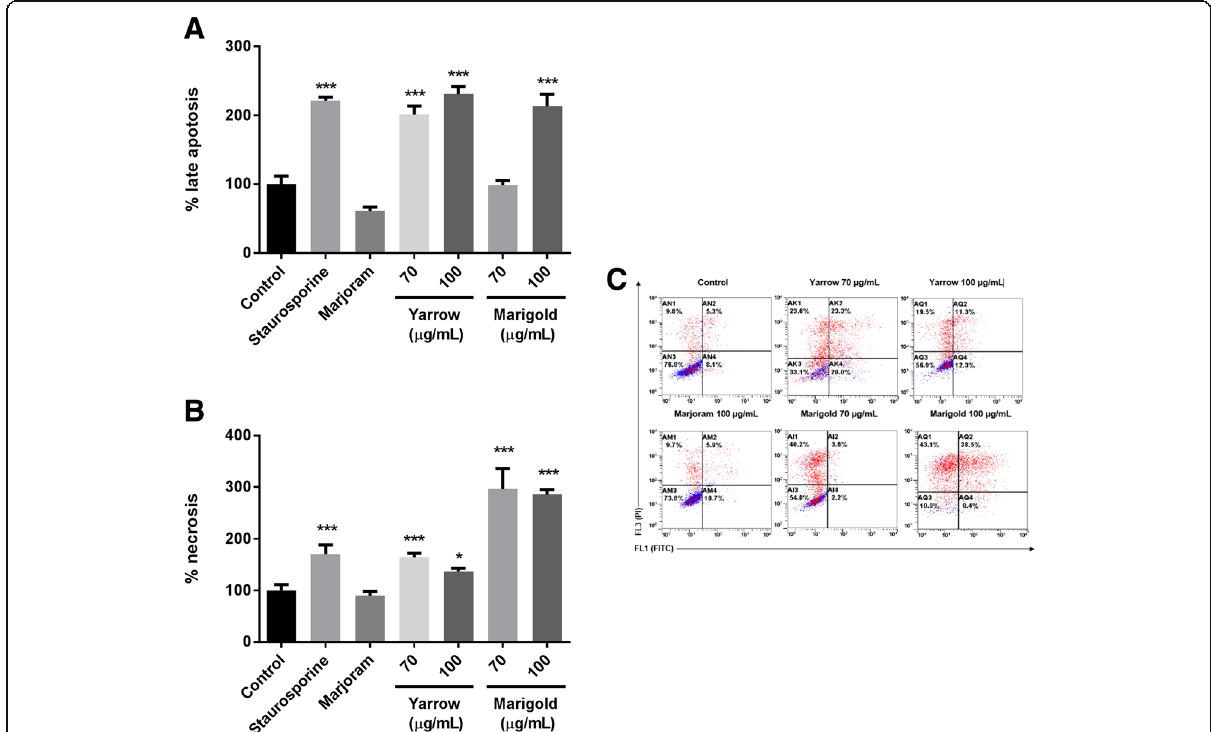
Fig. 5 Different phases of cell death after 24 h treatment with Asteraceae plants on MIA Paca-2. The % of apoptotic cells depending on Yarrow and Marigold SFE extracts ( a ) and the % of necrotic populations after those treatments ( b ). A representative flow cytometry diagram ( c ). Annexin V-FITC/PI double staining discriminates the live cells (Annexin V − /PI − ; bottom left quadrant), early apoptotic cells (Annexin V+/PI − ; bottom right quadrant), late apoptotic (Annexin V+/PI+; upper right quadrant), and necrotic or dead cells (Annexin V − /PI+; upper left quadrant). Data represent means ± S.E.M of at least four independent experiments each performed in triplicate. Asterisks indicate statistical differences in treated cells with respect to the control (non-treated cells, DMSO 0.1%). * p < 0.05; *** p <